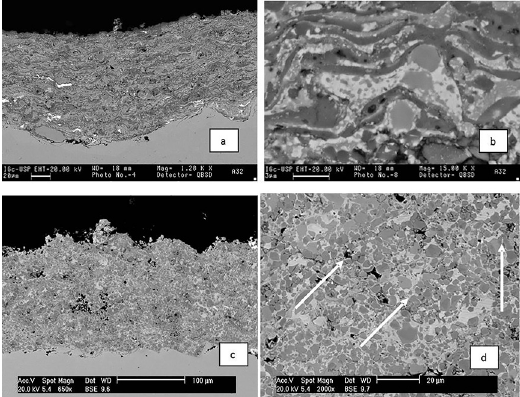
Figure 1. (a) Backscattered electron image showing the microstructure of nanostructured Cr C -25(Ni20Cr) coating. Note the relatively 3 2 uniform and dense structure, as well as good bonding with the substrate. The lamellae aspect of the coating is typical of structures produced by the HVOF process; (b) detail of (a) illustrating the distribution of fine carbides in the Ni20Cr matrix.; (c) backscattered electron image showing the microstructure of as-received Cr C -25(Ni20Cr) 3 2 coating. Note the presence of some heterogeneities; (d) detail of (c) showing pores as well as some oxide films between the